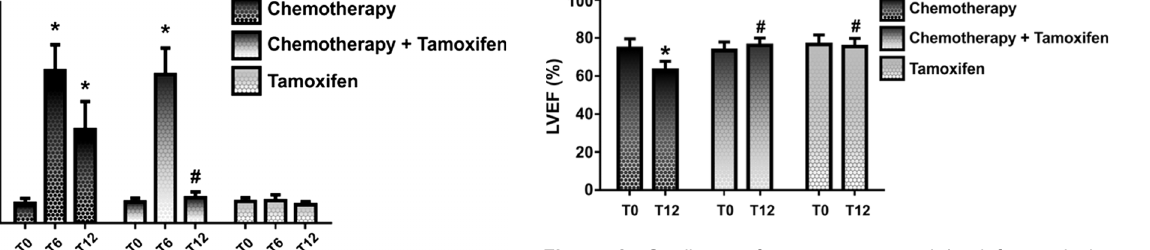
Figure 3. Cardiac performance assessed by left ventricular ejection fraction (LVEF) in the groups treated with chemotherapy alone, chemotherapy followed by tamoxifen, and tamoxifen alone. Data are reported as means±SD. *P , 0.01 compared to T0; # P , 0.01 compared to T12 in the group treated with chemotherapy alone (Bonferroni